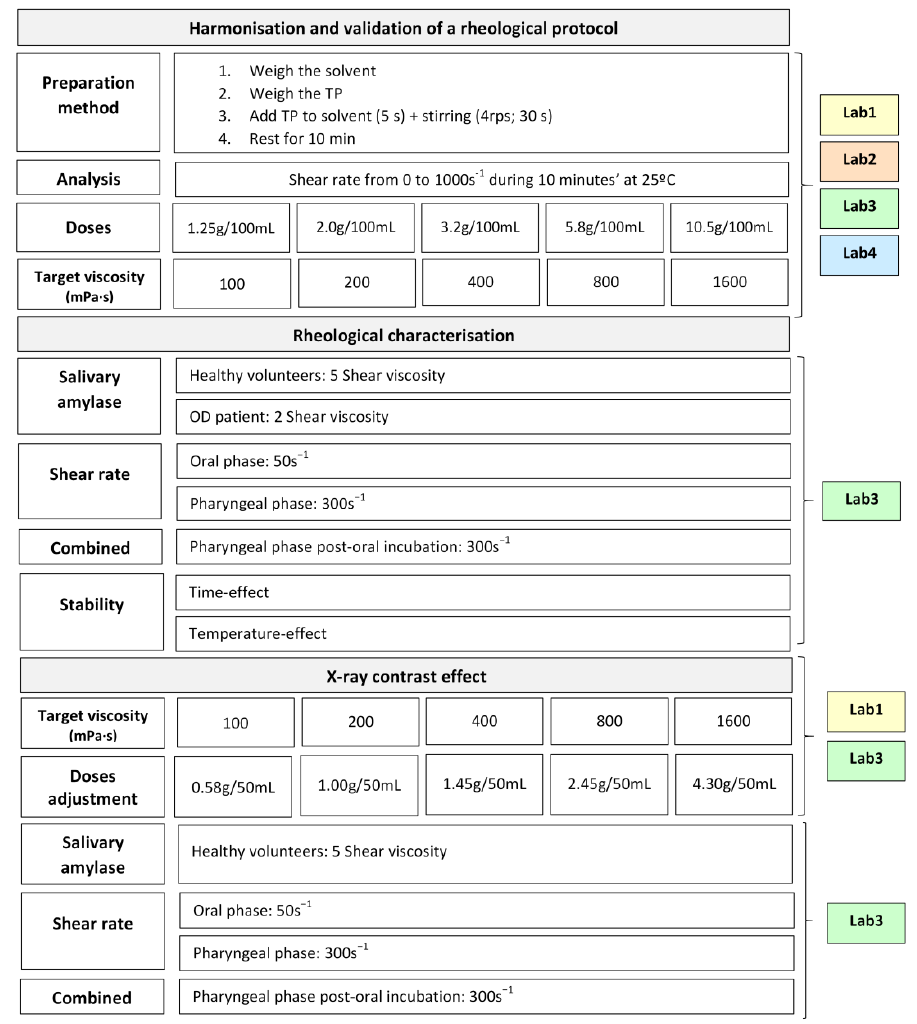
Figure 1. Study design showing the experiments, the measurements and the laboratories involved